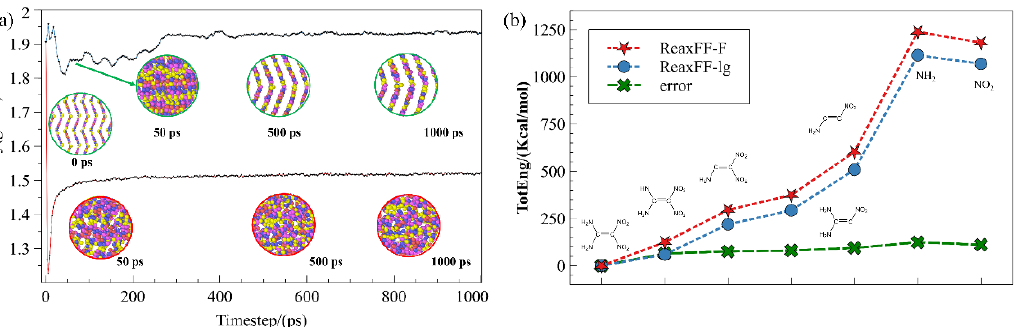
Figure 2. ( a ) the prediction of FOX-7 crystal density by two ReaxFF-lg and ReaxFF-F; ( b ) the descrip- tion of molecular energy obtained from the two force fields.